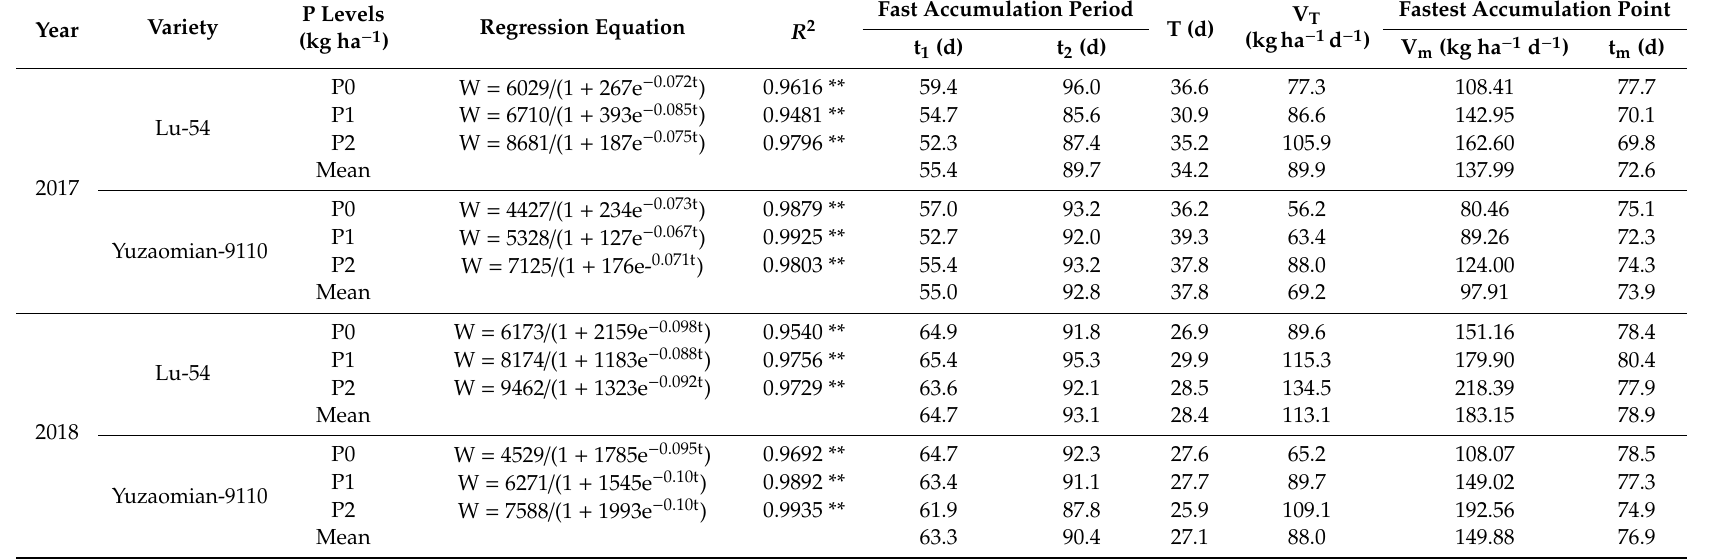
Table 5. Dynamic models and the maximum accumulation rate of biomass (V M ), average speed of biomass accumulation (V T ), start time of the biomass rapid-accumulation period (t 1 ), termination time of the biomass rapid-accumulation period (t 2 ), duration of the biomass rapid-accumulation period (T), and occurrence time of maximum accumulation rate of biomass (t m ) in reproductive organ of cotton plants for Lu-54 and Yuzaomian-9110 in 2017 and